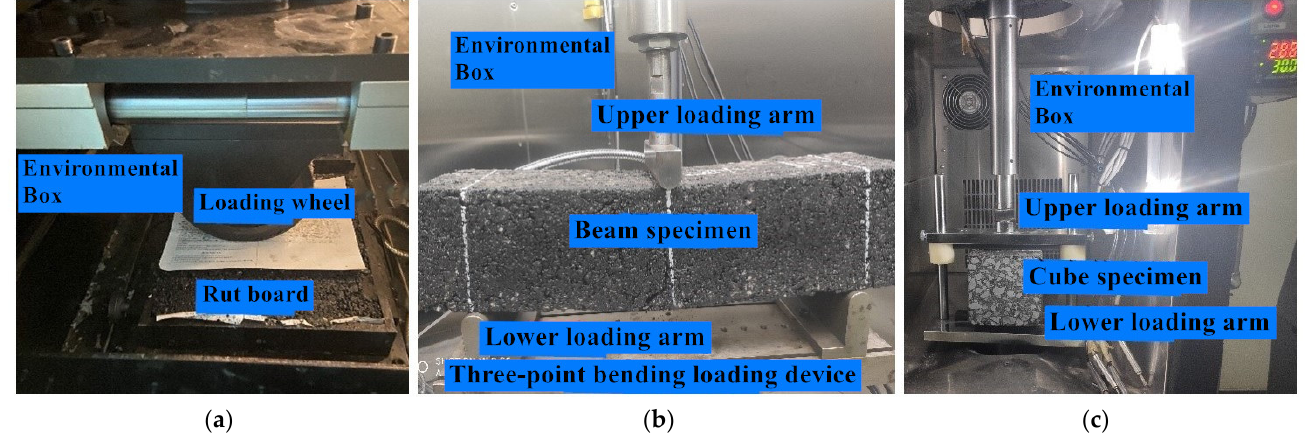
Figure 4. Test loading device: ( a ) rutting tests; ( b ) bending creep tests; ( c ) split fatigue tests.